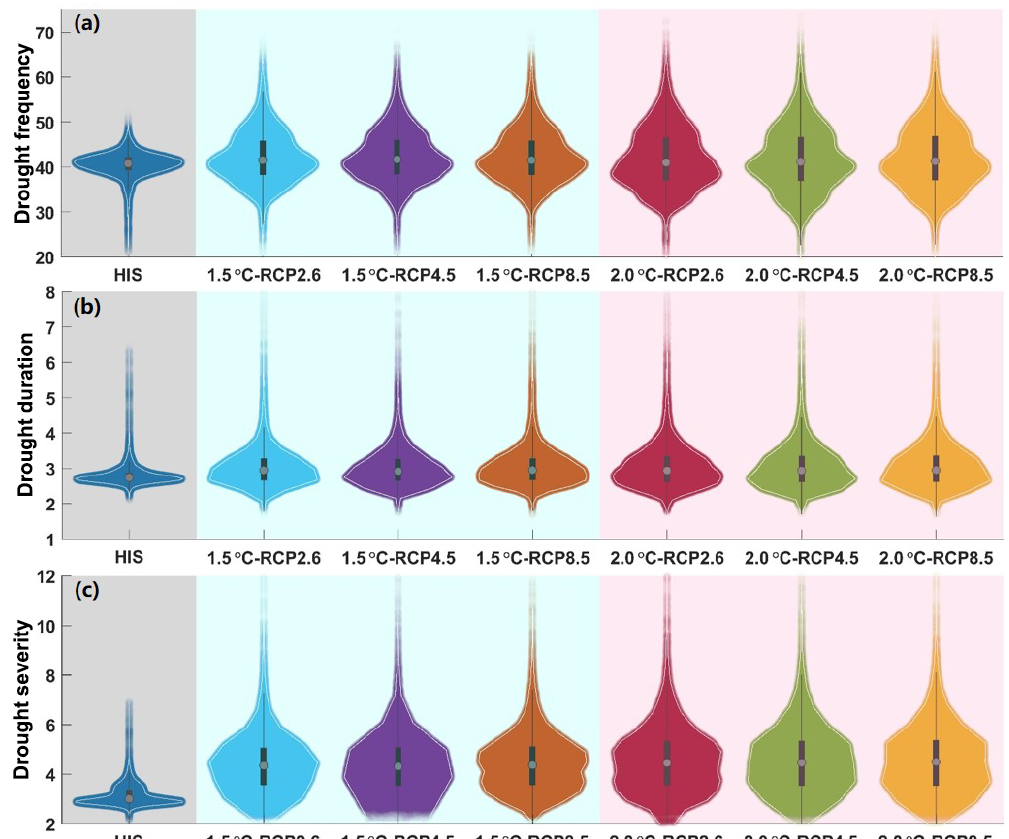
Figure 6. Distributions for drought characteristics under different time